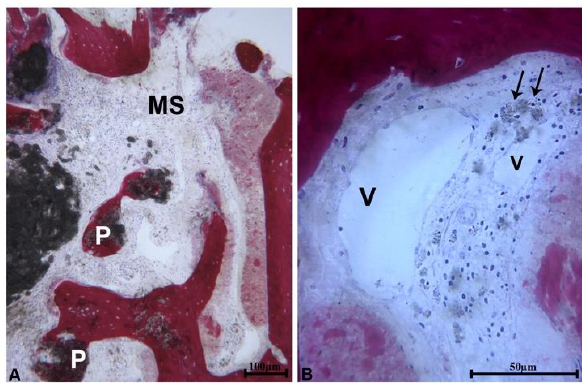
Figure 3. ( a ) Marrow spaces (MS) and residual biomaterial particles (P) partially surrounded by newly formed bone were detected. In some areas, a small amount of the residual biomaterial was completely surrounded by newly formed bone. ( b ) Blood vessels (V) with different sizes were observed adjacent to the newly formed bone. Some lymphocytes around the residual biomaterial particles that showed signs of degradation (black arrows) were present in the bone marrow (acid fuchsin – toluidine blue, 40 and 200X).